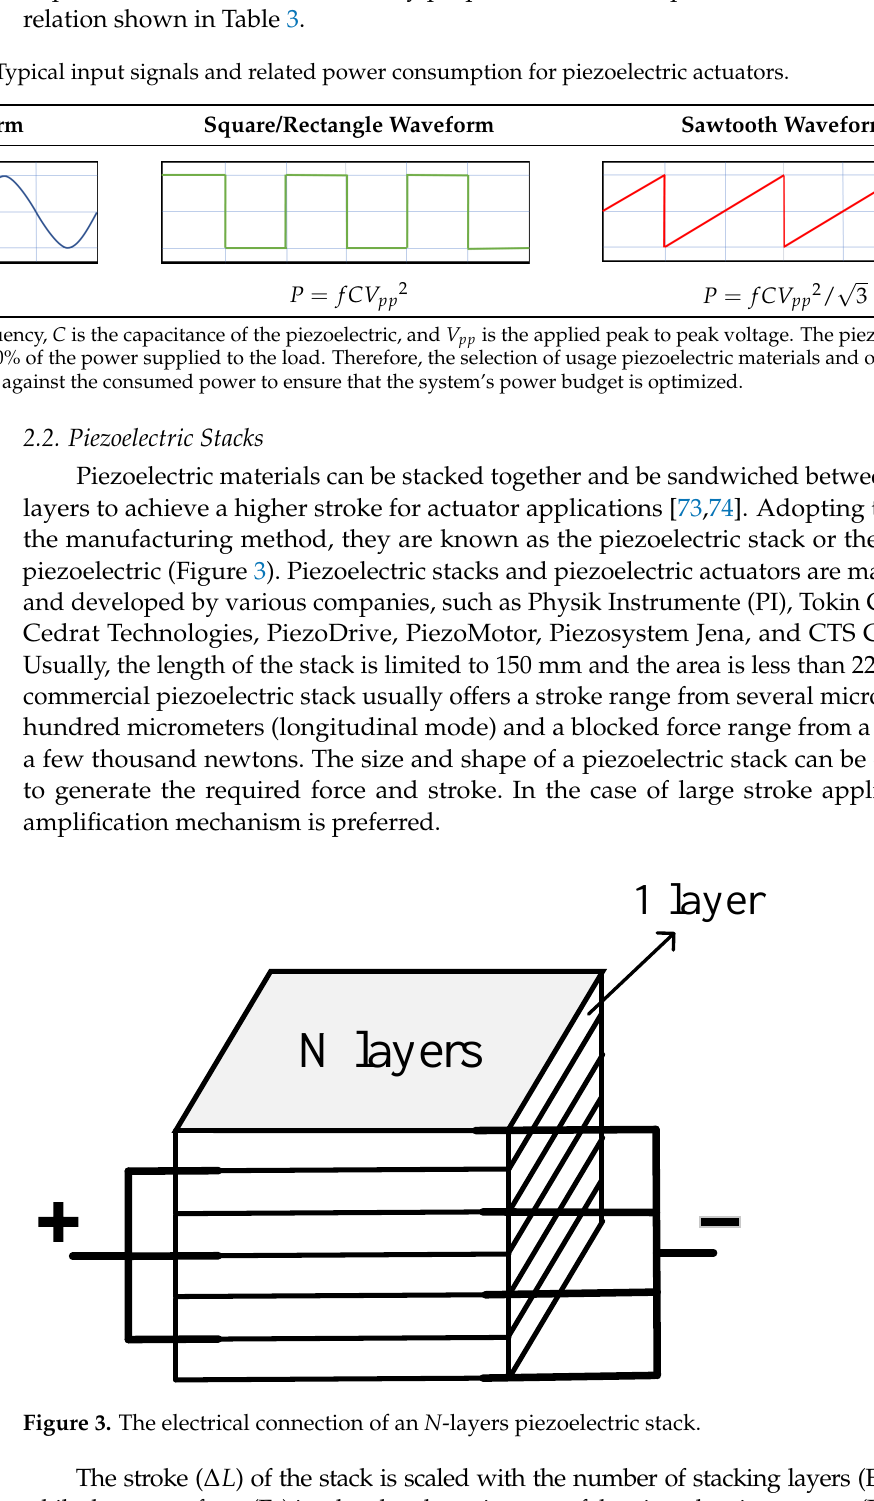
Table 3. Typical input signals and related power consumption for piezoelectric actuators. Sinusoidal Waveform